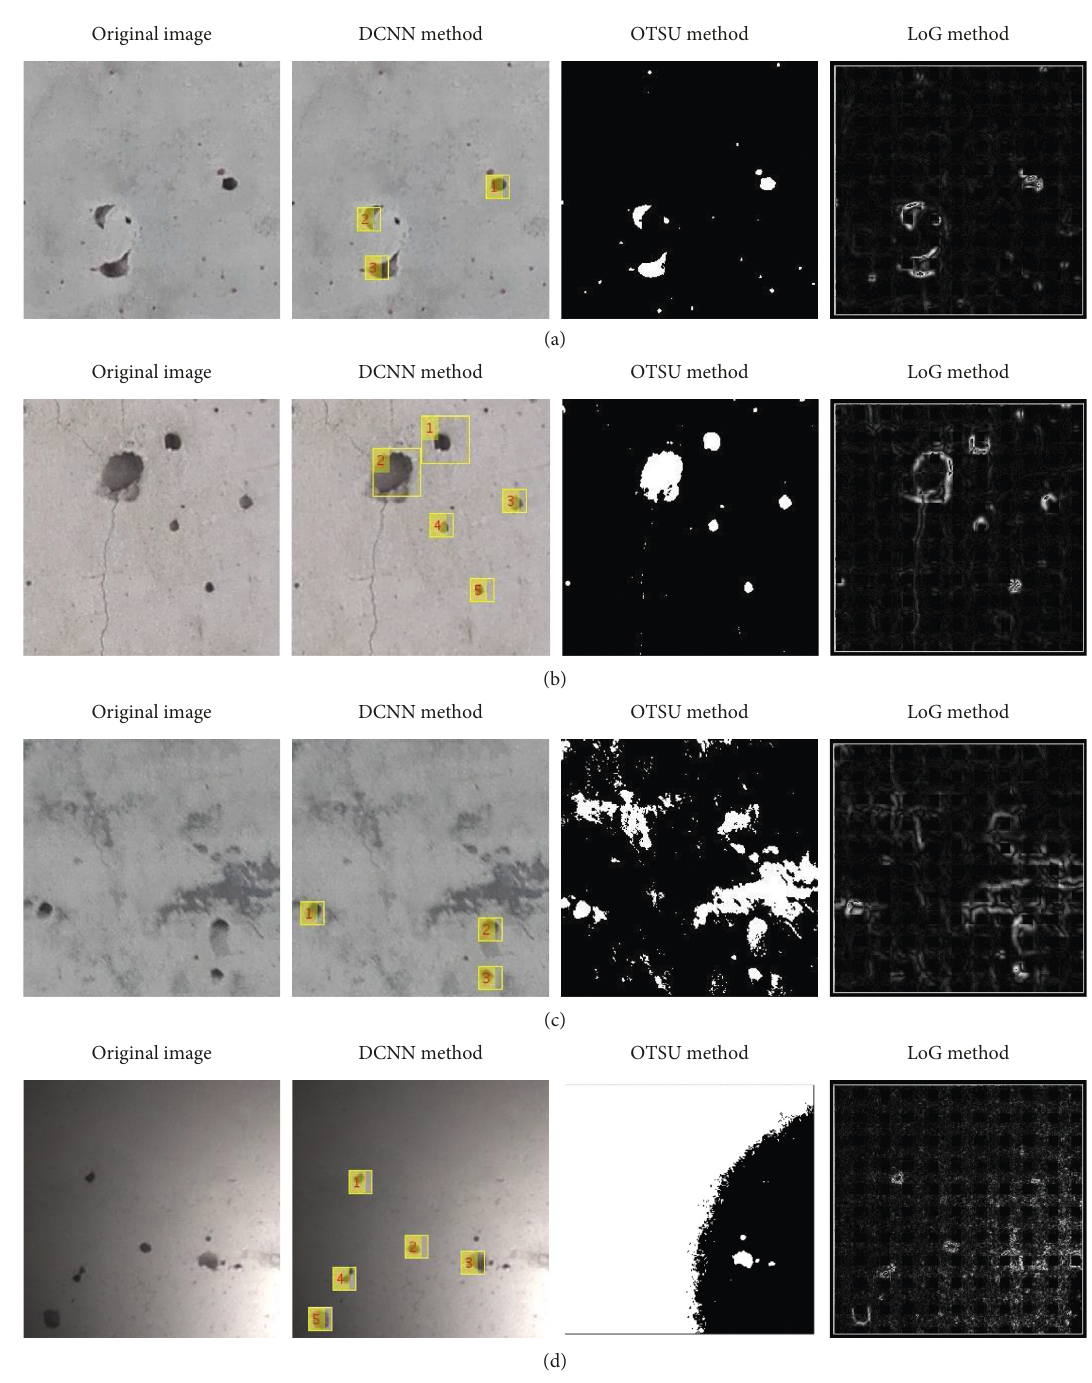
Figure 12: Comparison of image recognition results under different methods. (a) Type 1: only bugholes; (b) type 2: both cracks and bugholes; (c) type 3: both color-differences and bugholes; (d) type 4: uneven